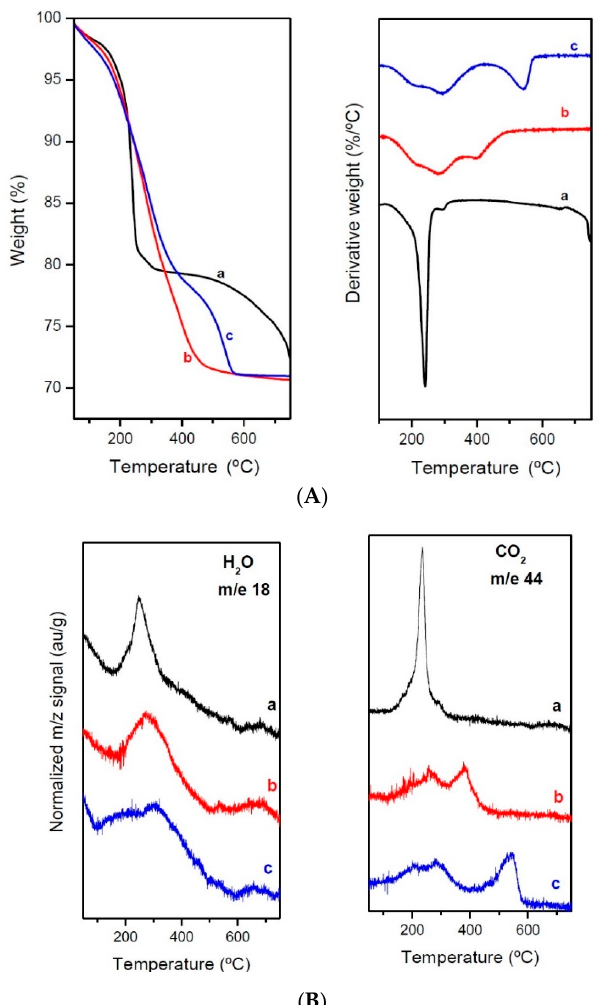
Figure 3. Thermogravimetry / di ff erential thermal analysis (TG / DTA) patterns ( A ) and mass spectrometry (MS) traces (H 2 O and CO 2 ) ( B ) corresponding to the decomposition of the hydroxycarbonate